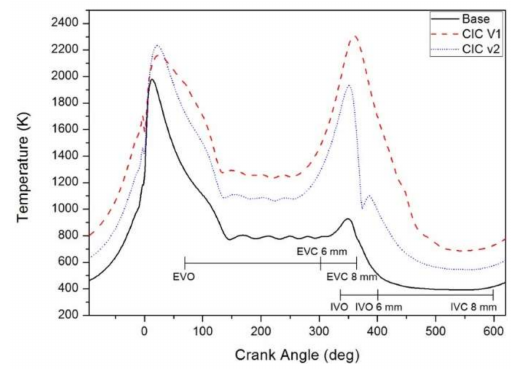
Figure 4. Temperature variation for different recompression